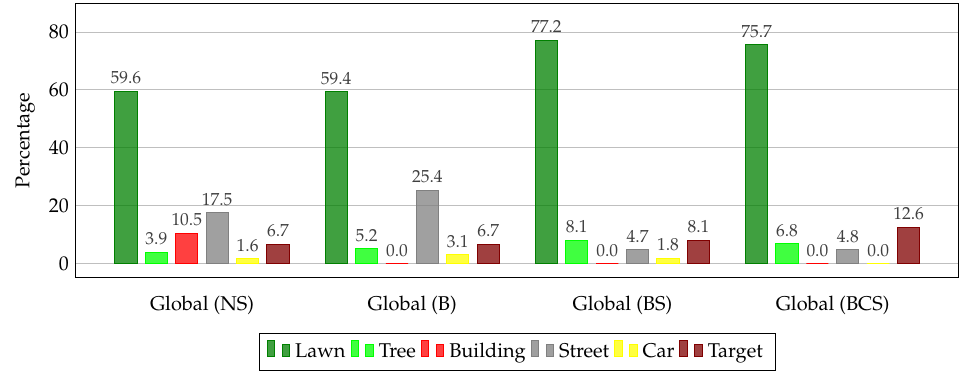
Figure 9. Proportions of traversed ground labels for different semantically constrained flight